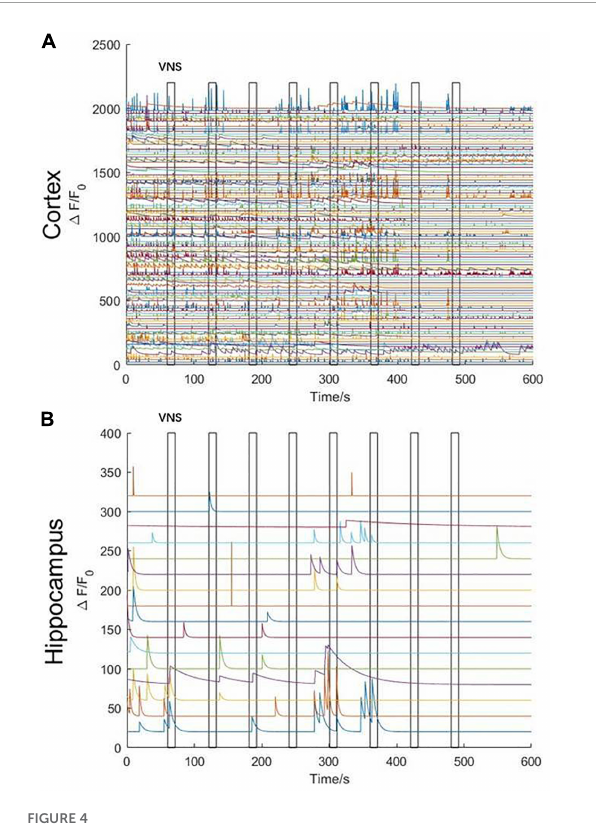
FIGURE4 Characteristics of calcium signaling of neurons in the cerebral cortex and hippocampal CA1 under isoflurane anesthesia during VNS. (A) Curve diagram of calcium signaling of neurons in the cerebral cortex during VNS. (B) Curve diagram of calcium signaling of neurons in the hippocampal CA1 during VNS. Narrow gray rectangles indicate time of each VNS application (lasting 10 s). Y-axis indicates neuron